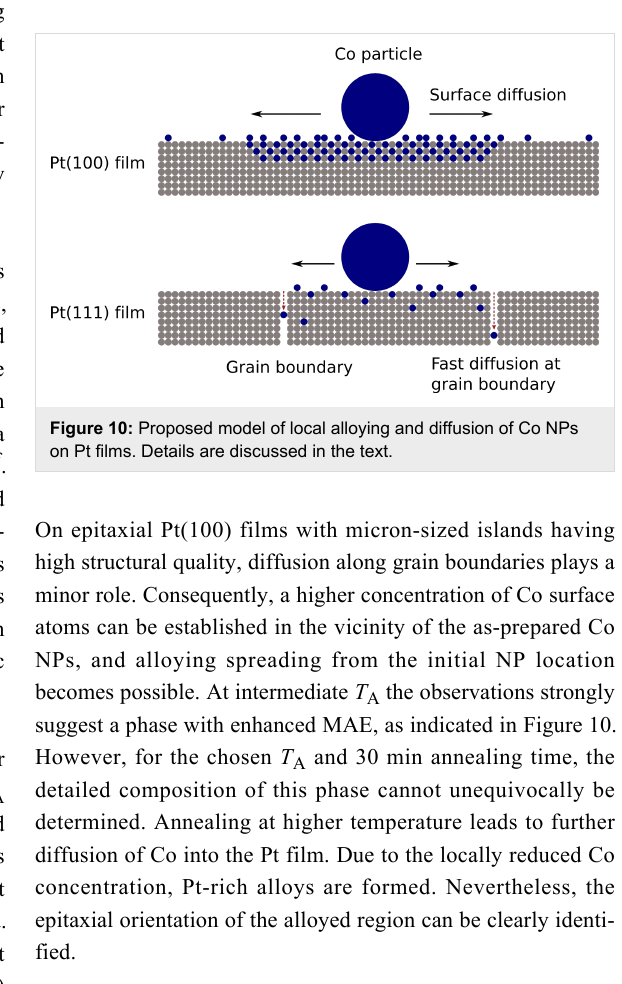
On epitaxial Pt(100) films with micron-sized islands